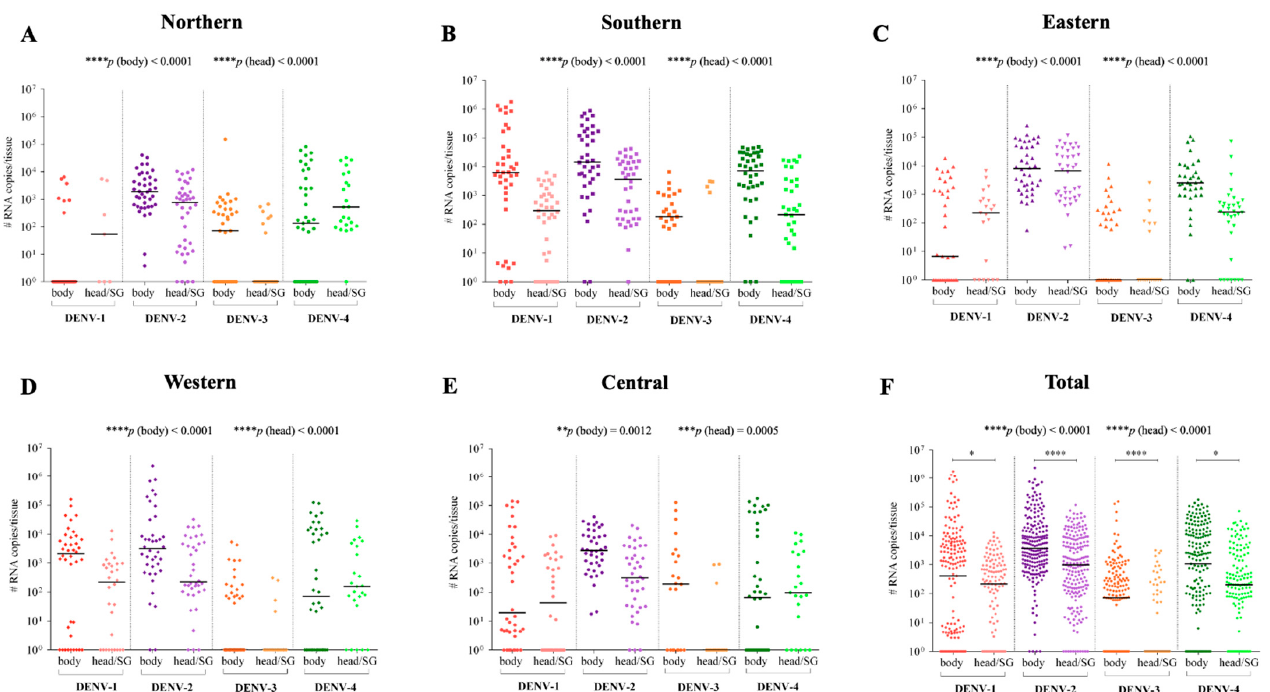
eastern; W = western; S = southern; C = central. p values > 0.05 (non-significant) are represented as “ns”. p values ≤ 0.05, ≤ 0.01, ≤ 0.001, and ≤ 0.0001 are summarized with one (*), two (**), three (***), and four (****) asterisks, respectively.